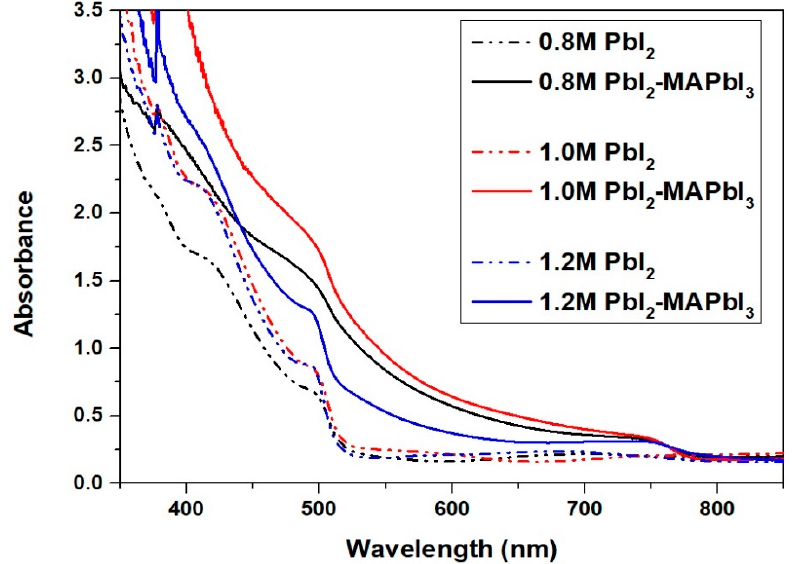
Figure 3. UV-Vis absorption spectra for PbI 2 coated mesostructured TiO 2 substrates using different PbI 2 solution concentration (shown as dotted lines) and corresponding perovskite films (shown as solid lines).